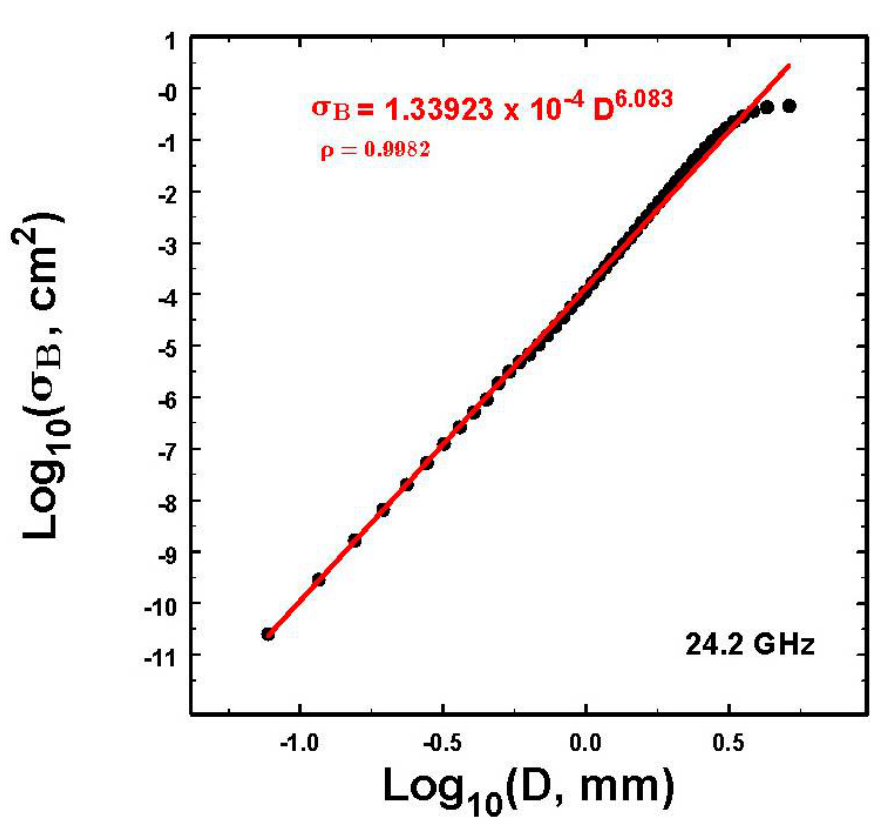
Figure 1. A plot of the T-matrix computed [14] backscatter cross-sections σ B of spherical raindrops of size D (appropriate for vertical pointing observations) corresponding to the Micro-Rain Radar (MRR). The validity of these cross-sections is illustrated in Figure A4 in Appendix A. While there is a slight roll-off at the very largest D , these drops rarely contribute much to most rainfall rates or even Z , so that these deviations are likely usually inconsequential.